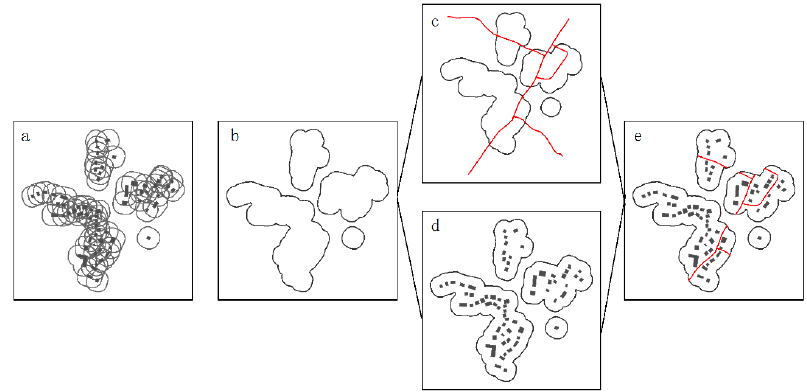
Figure 11. Extraction of selection units: ( a ) building buffering; ( b ) merging of buffered polygons; ( c ) conducting an overlap with roads; ( d ) conducting an overlap with buildings; ( e ) assigning buildings and roads to form selection units.